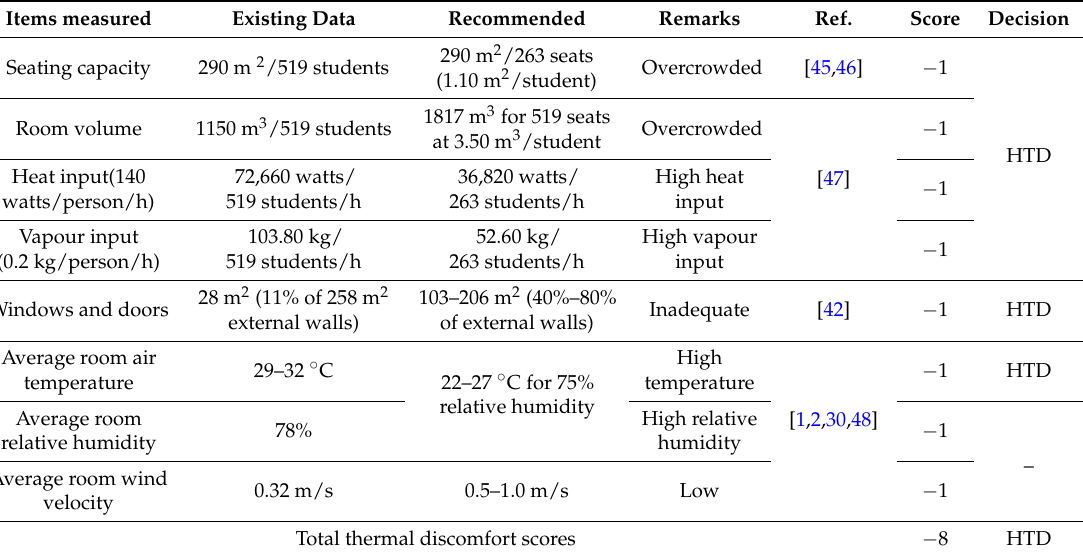
Table 2. Measurement of indoor space and environmental conditions in LTH-3.